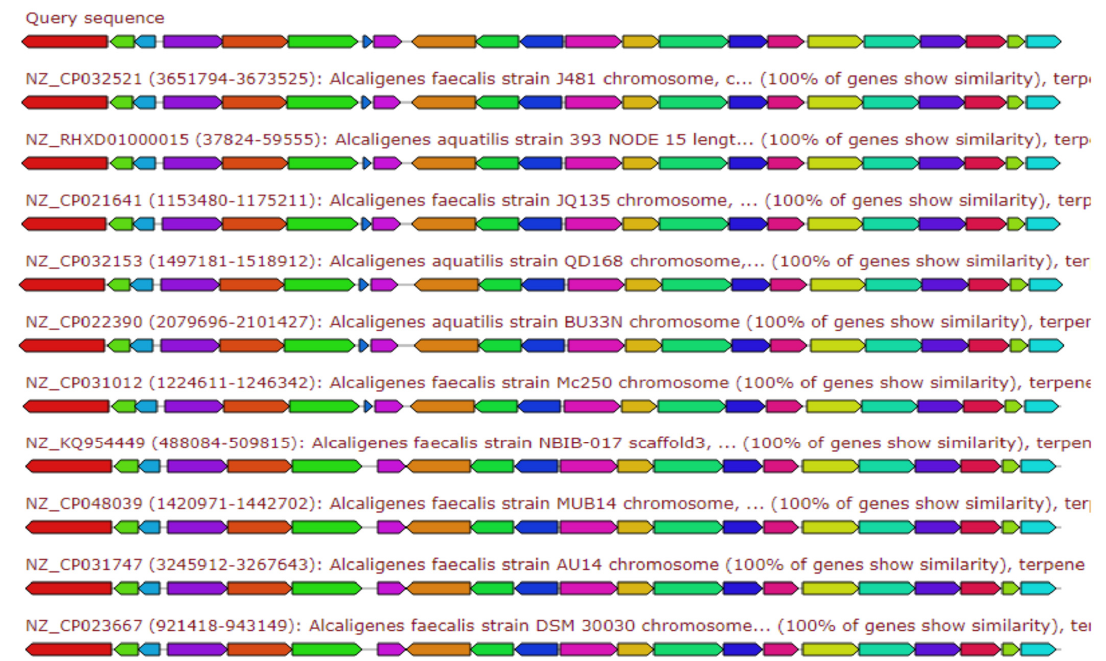
Figure 6. Gene arrangement of β -lactone containing protease inhibitors showing top 10 Alcaligenes faecalis strains homologous to query sequence of A. faecalis isolate MZ921504. Putative biosynthetic genes presented in red, additional biosynthetic genes in orange, transport-related genes in blue, regulation-related genes in green color, resistance genes in pink, TTA codon in dark pink and grey represent other genes.